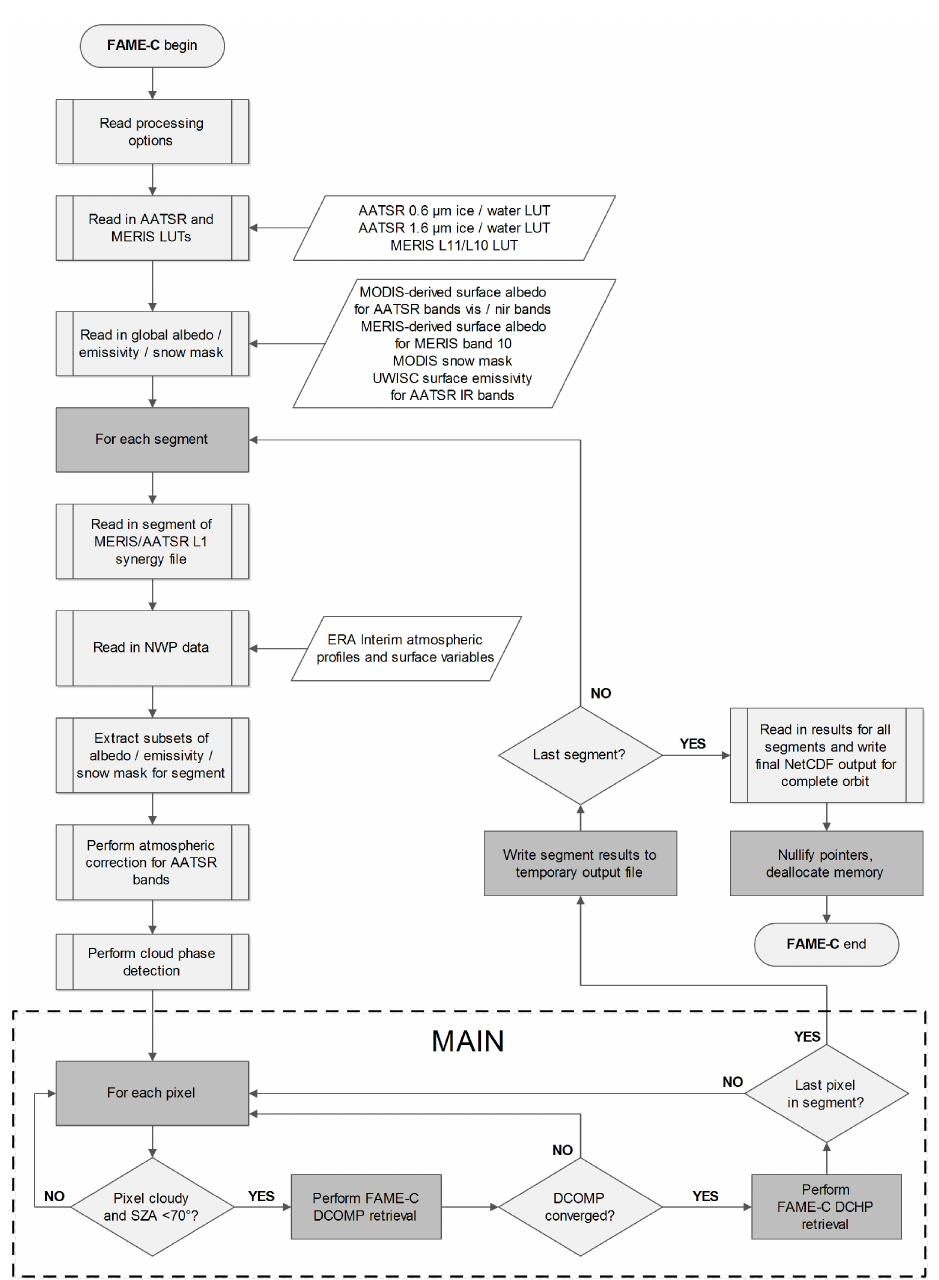
Figure 2. FAME-C algorithm flowchart with two main retrieval steps DCOMP (Daytime Cloud Optical and Microphysical Properties) and DCHP (Daytime Cloud top Height Properties) and input and output